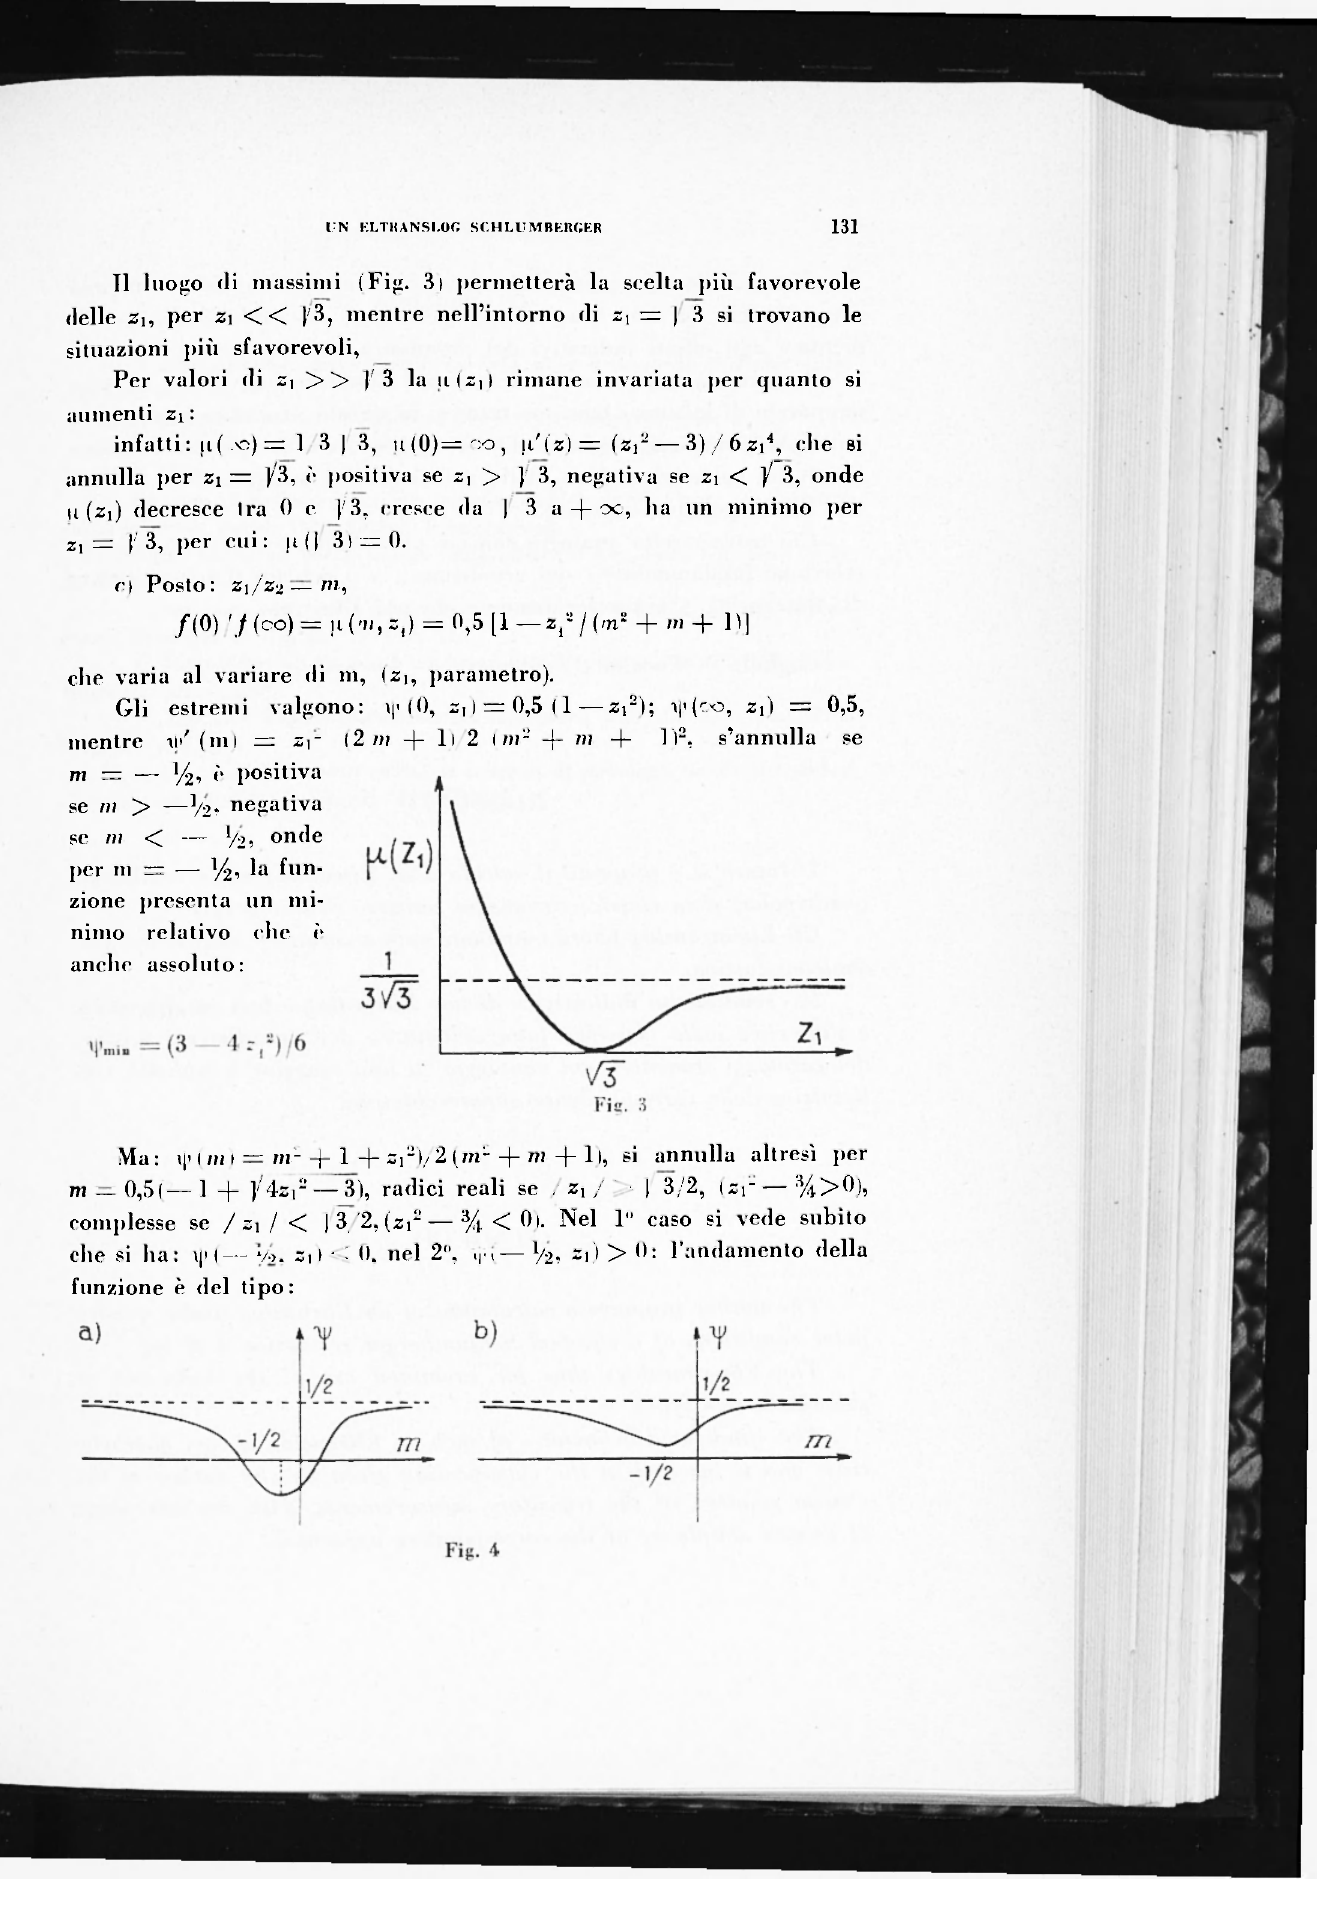
Il luogo (li massimi (Fig. 3| permetterà la scelta più favorevole delle Zi, per Zi < < }'3, mentre nell'intorno (li z, = ] 3 si trovano le situazioni più